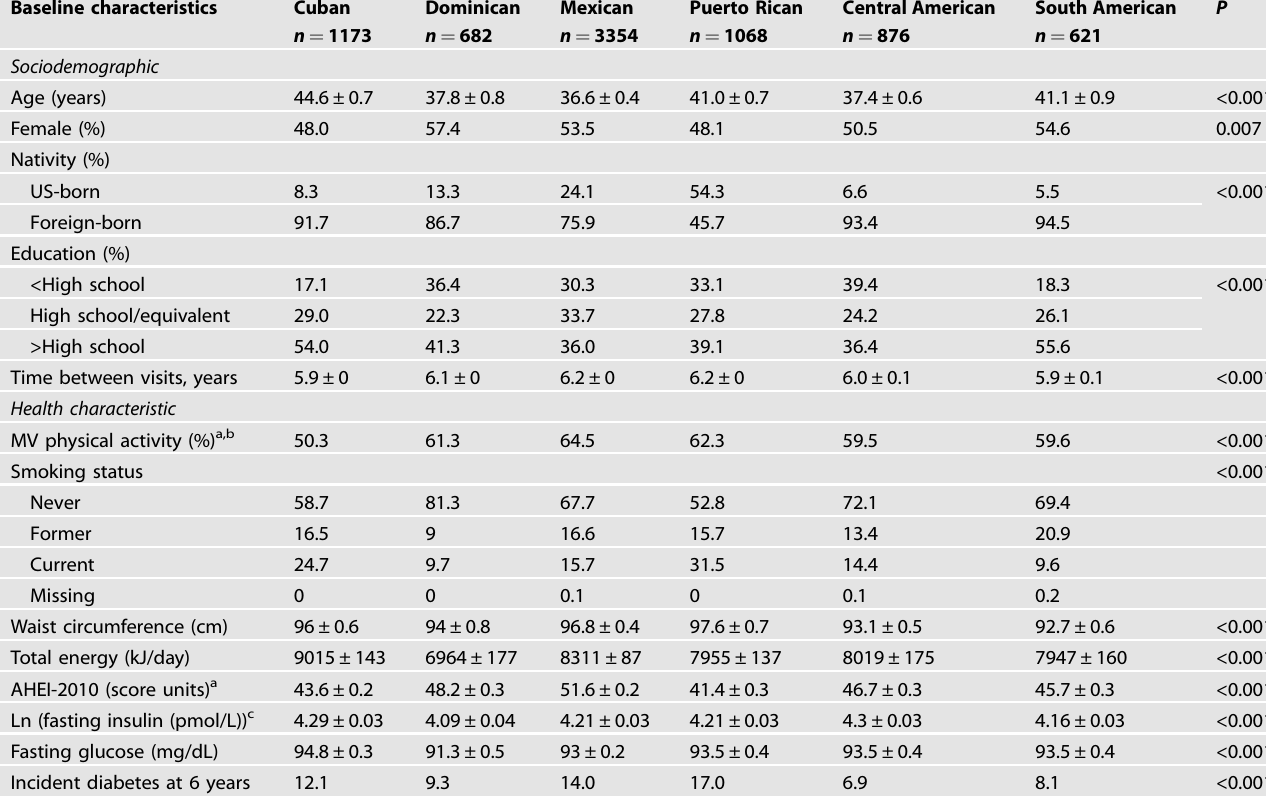
Table 1. Baseline characteristics and 6-year diabetes incidence by Hispanic/Latino heritage group in HCHS/SOL ( n = 7774) a . Baseline